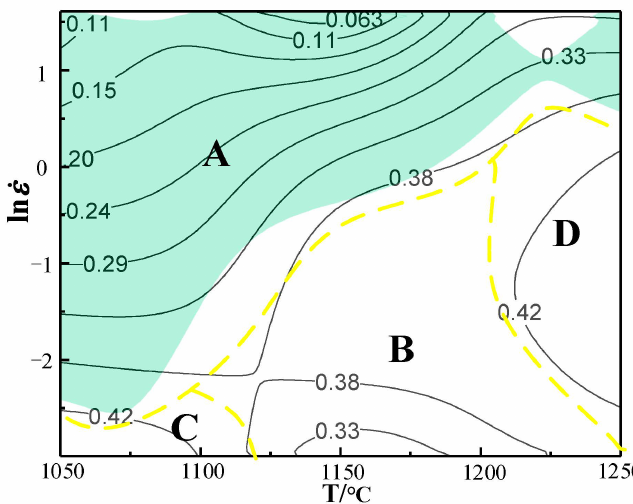
Figure 18. Different regions of the thermal processing map under the condition of a strain of